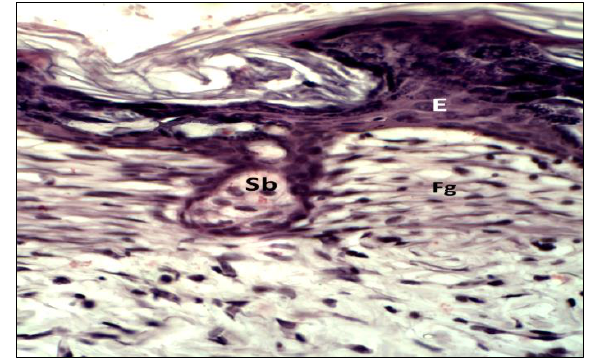
Figure, 20: Magnified section of skin (28 days post treatment with amniotic membrane) shows complete epithelization (E) fibrogenesis (fg) and sebaceous gland (Sb). H and E, 400x.